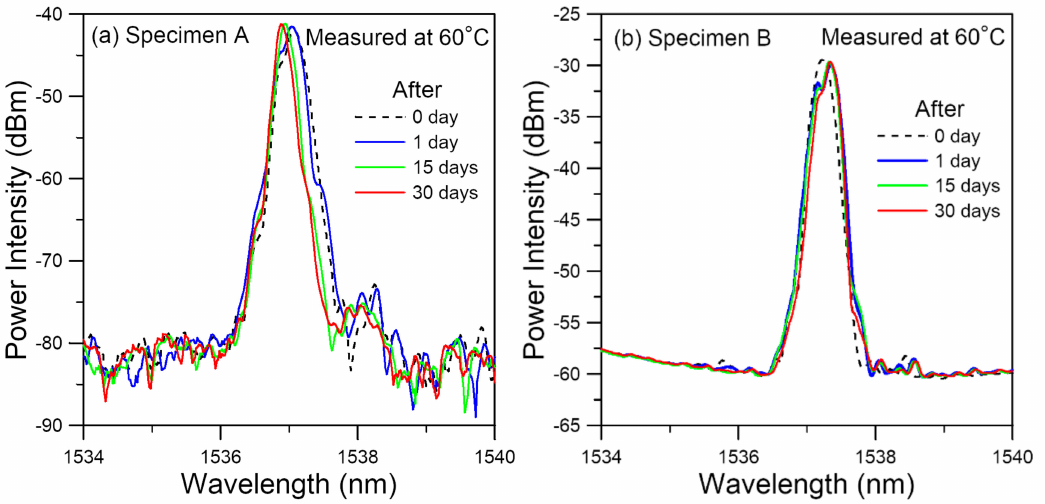
Figure 5. FBG spectra shows little changes during the soaking process in both specimens ( a ) A and ( b ) B, probably due to the mutual balance between the antagonistic effects of moisture-induced expansion and thermal aging-induced